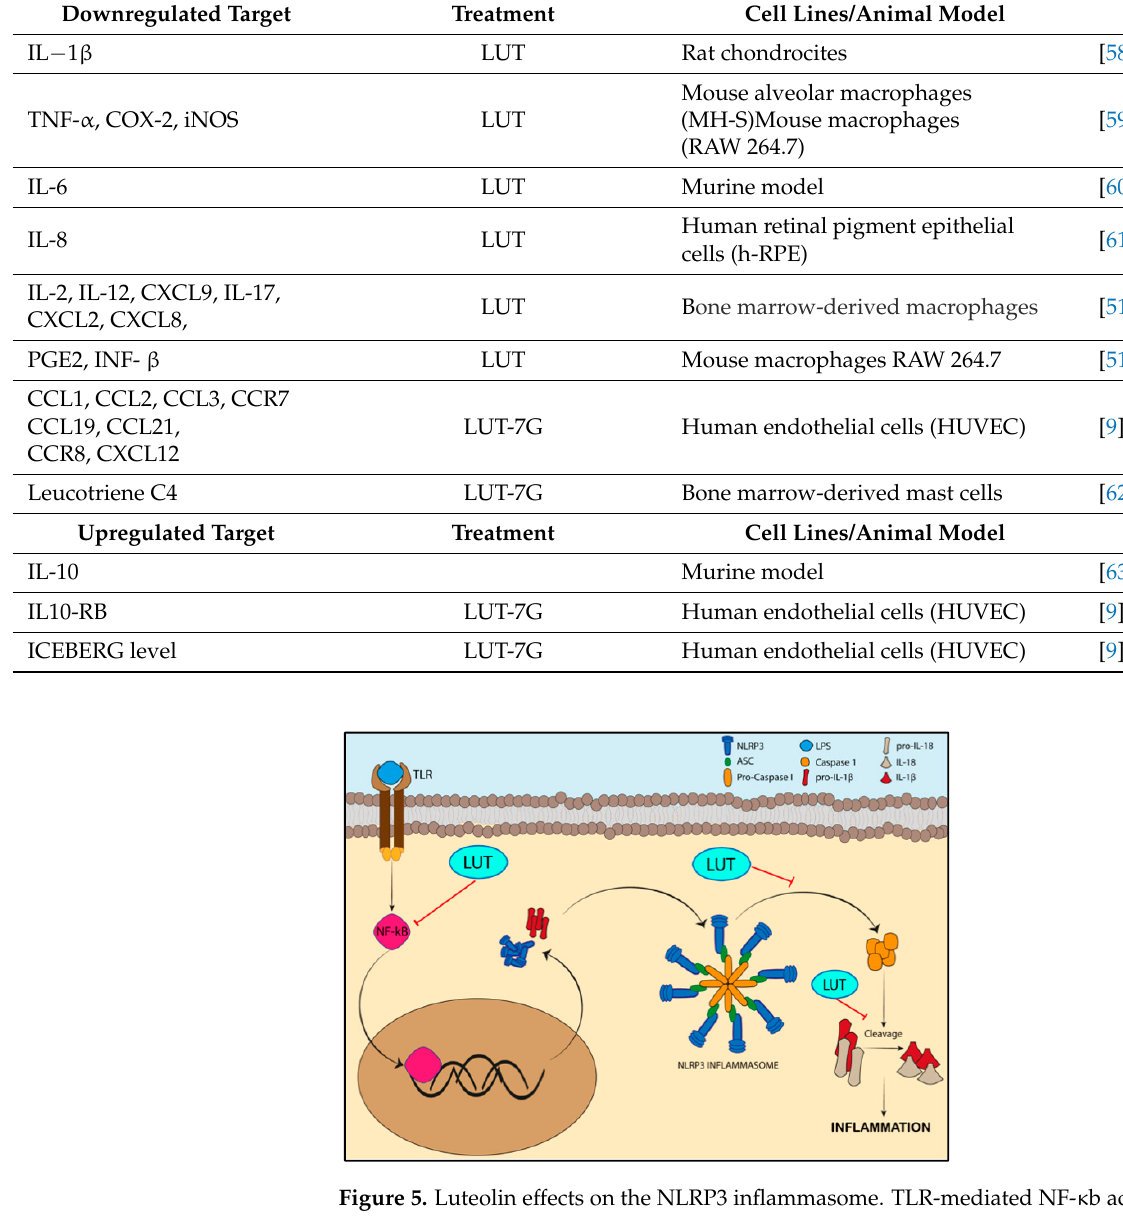
Figure 5. Luteolin effects on the NLRP3 inflammasome. TLR-mediated NF- κ b activation induces the transcription of NLRP3 required for NLRP3 inflammasome assembly and pro-IL-1 β . Luteolin could interfere with NF- κ b, blocking the upstream process involved in the inflammasome recruitment. Moreover, LUT decreases the cleavage of pro-caspase-1 and pro-IL − 1 β , a downstream event of NLRP3 inflammasome activation.